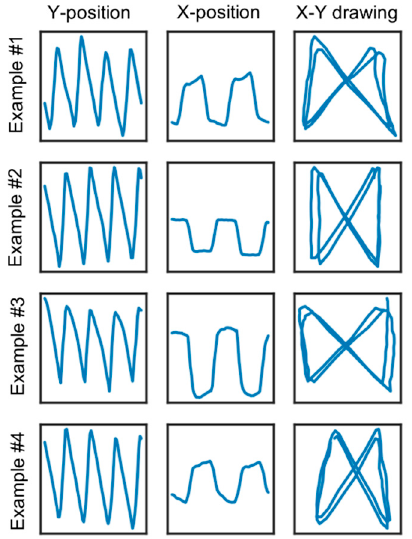
Figure 2. Examples of segments used to train the deep neural networks. Four examples from four distinct participants are shown. After time normalization at 40 samples per strides, trajectory signals (Figure 1) were sliced into 80 sample non-overlapping segments. These segments were fed into the first one dimensional (1-D) convolutional layer as tensors of size (batch size × 80 × 2).